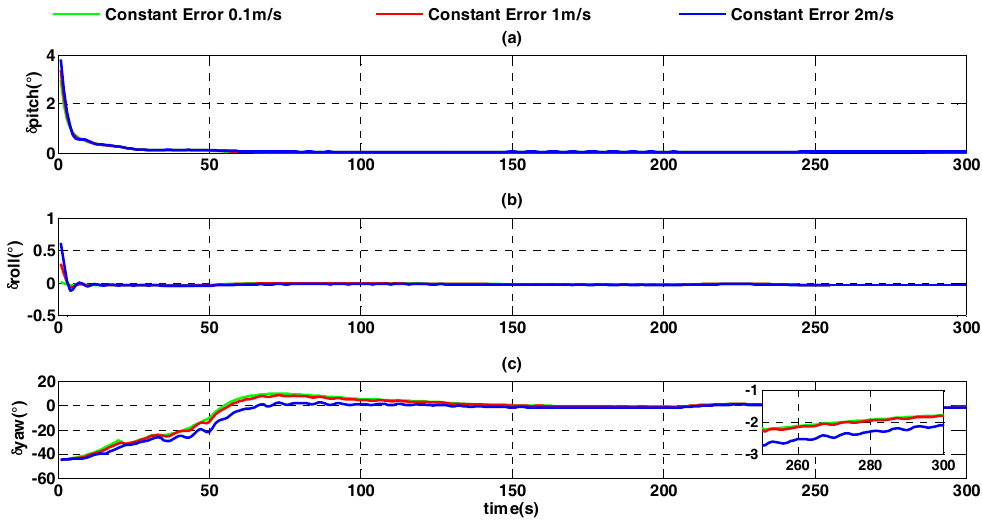
Figure 11. Alignment error curves of different constant errors. ( a ) The error curves of pitch angle; ( b ) the error curves of roll angle; ( c ) the error curves of heading angle.